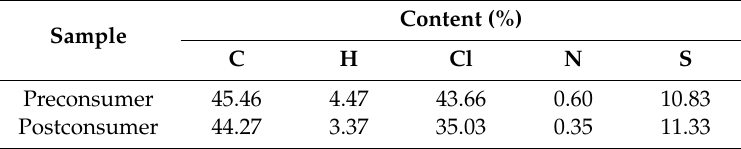
Table 1. Chemical analysis of the pre- and postconsumer waste.